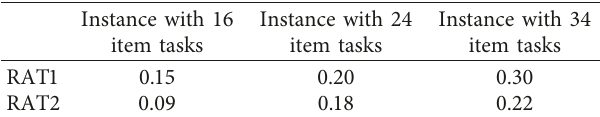
Table 10: Comparison for three algorithms on average deviation